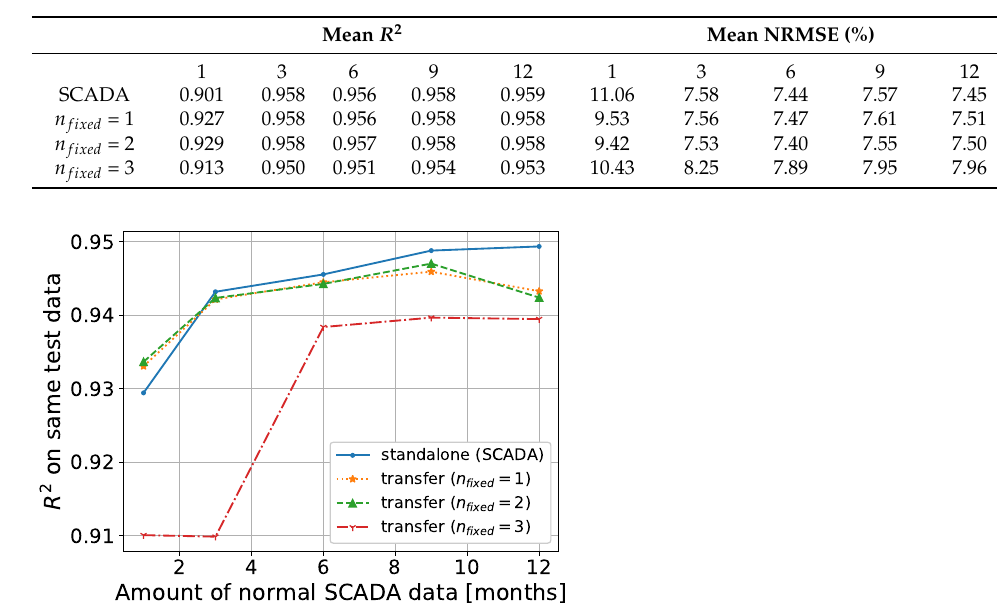
Figure 12. Standard deviation of R 2 value for ANN for different amounts of training data and knowledge transfers. Table 1. Prediction performance of ANN for different amounts of training data and knowledge transfers.